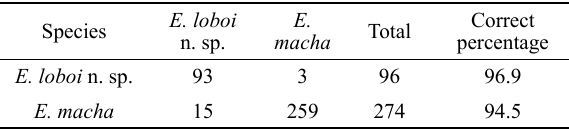
Table 2. – Classification matrix showing the cross-validated classification of each Ensis species.